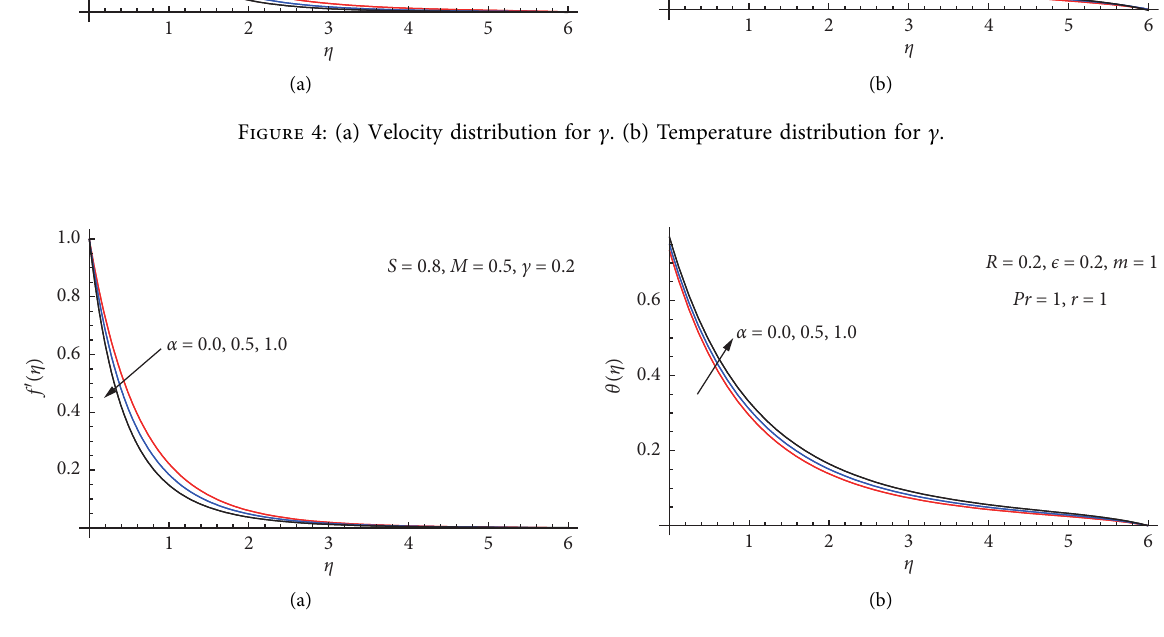
Figure 5: (a) Velocity distribution for α . (b) Temperature distribution for α .